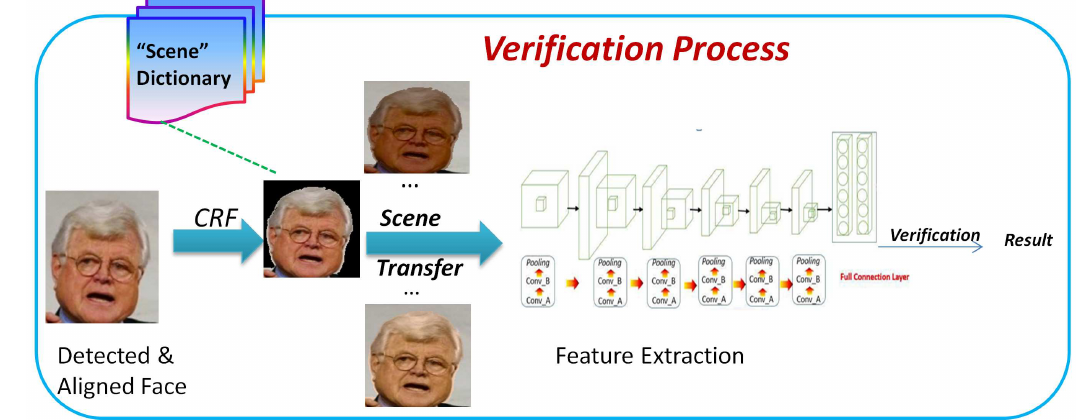
Figure 9. The semantic features’ extraction